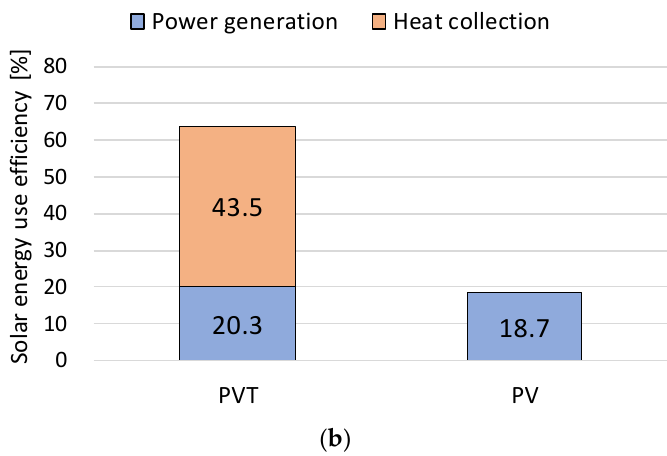
Figure 11. Solar energy utilization efficiency of PVT and PV: ( a ) summer; ( b ) winter.